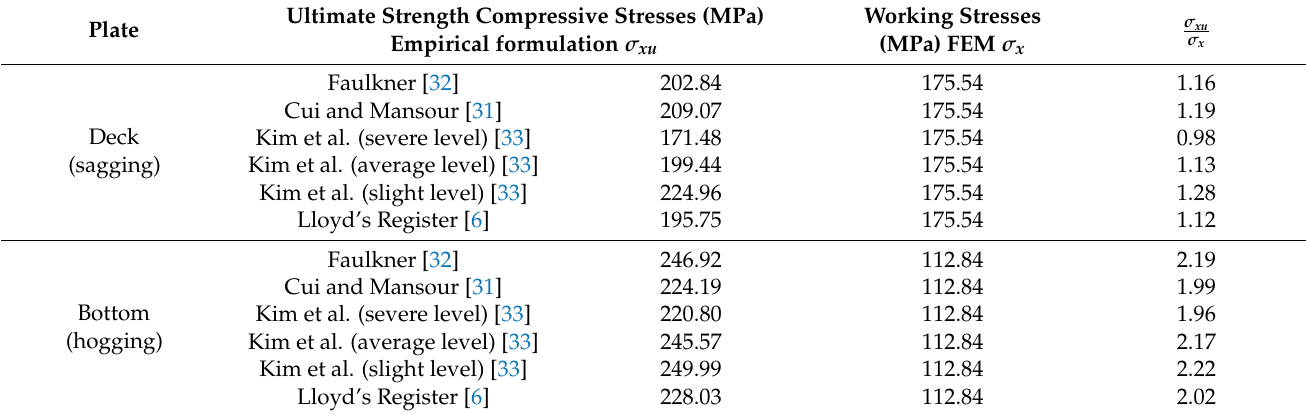
Table 9. Summary of ultimate strength and working stresses of unstiffened plates of